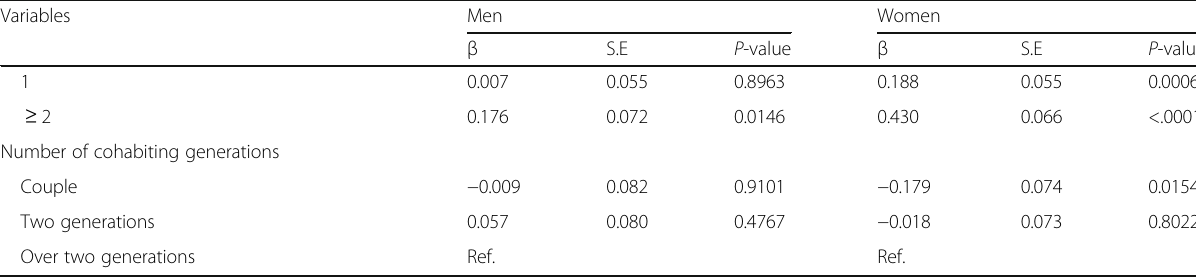
Table 2 Results of analysis of factors associated with CES-D 10 scores (Continued)